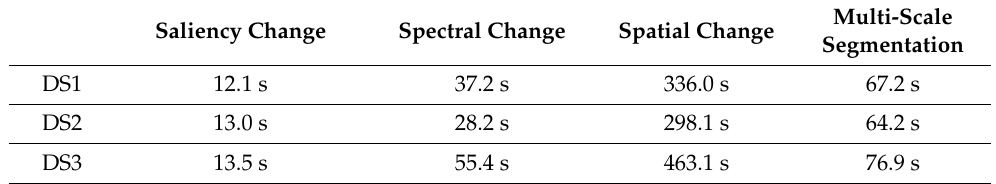
Table 6. Running time of different components of the proposed